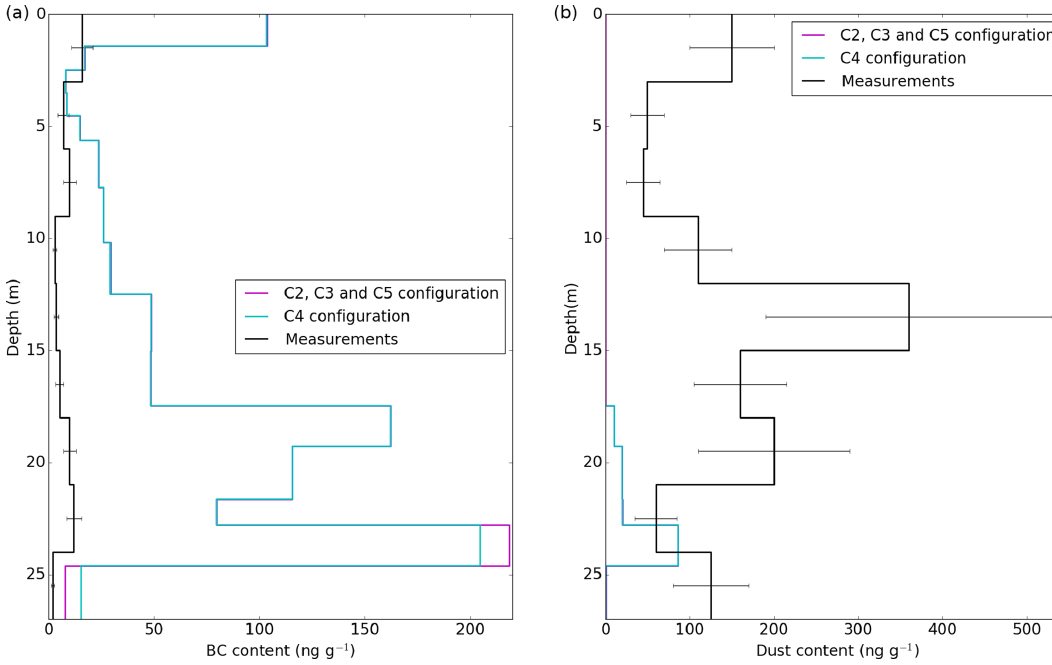
Figure 6. BC (a) and dust (b) concentrations at the Col de Porte on 11 February 2014.